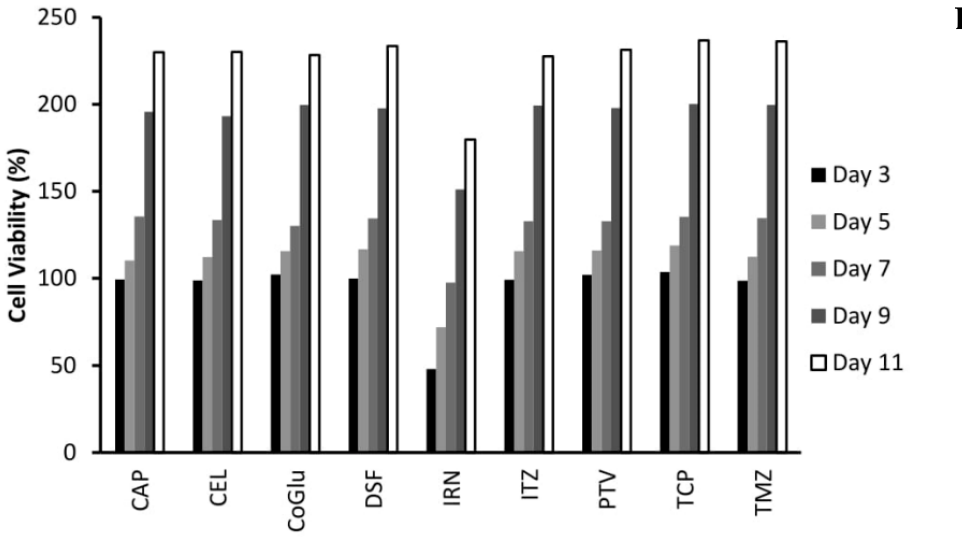
Figure 4. The influence of the single drugs on the recurrence rate of GBM 4 ( A ) and GBM 1 ( B ) over an 11-day period. The concentration of each drug was 5 log nM.